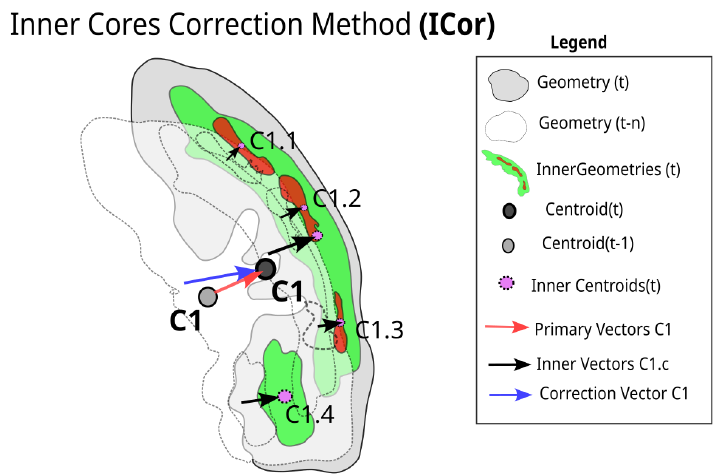
Figure 7. Schematic for Inner Cores method. The black arrows represent the displacement vectors for each inner cell. The average of black arrows is the blue arrow which replaces the primary displacement vector (red